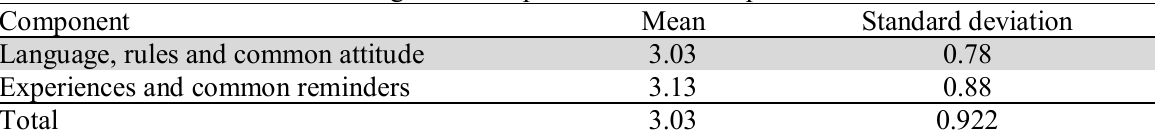
Mean and standard deviation of cognitive components of social capital Component Language, rules and common attitude Experiences and common reminders